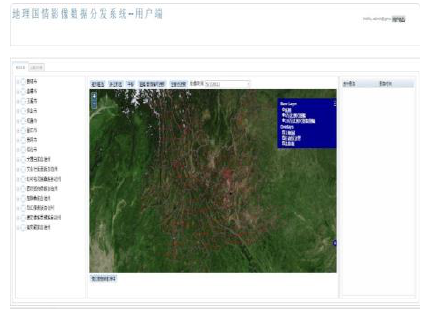
Figure 6. Image big data management system